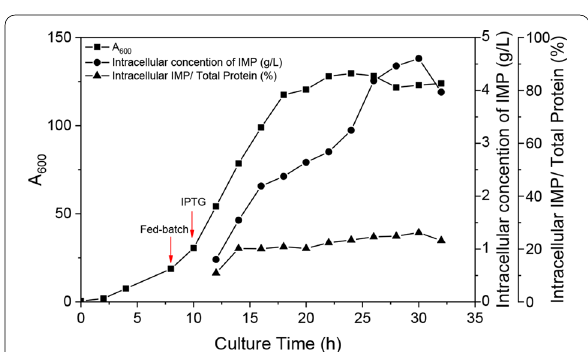
Fig. 6 Profile of high‑cell‑density fermentation of B. subtilis SCK22/ pHT7‑IMP in a 5‑L